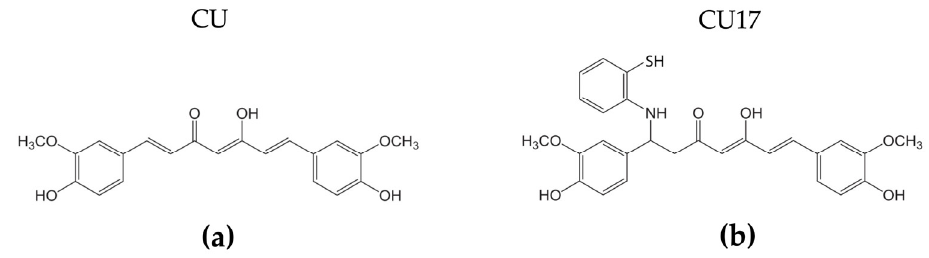
Figure 1. ( a ) Structure of curcumin (CU) and ( b ) curcumin derivative CU17.